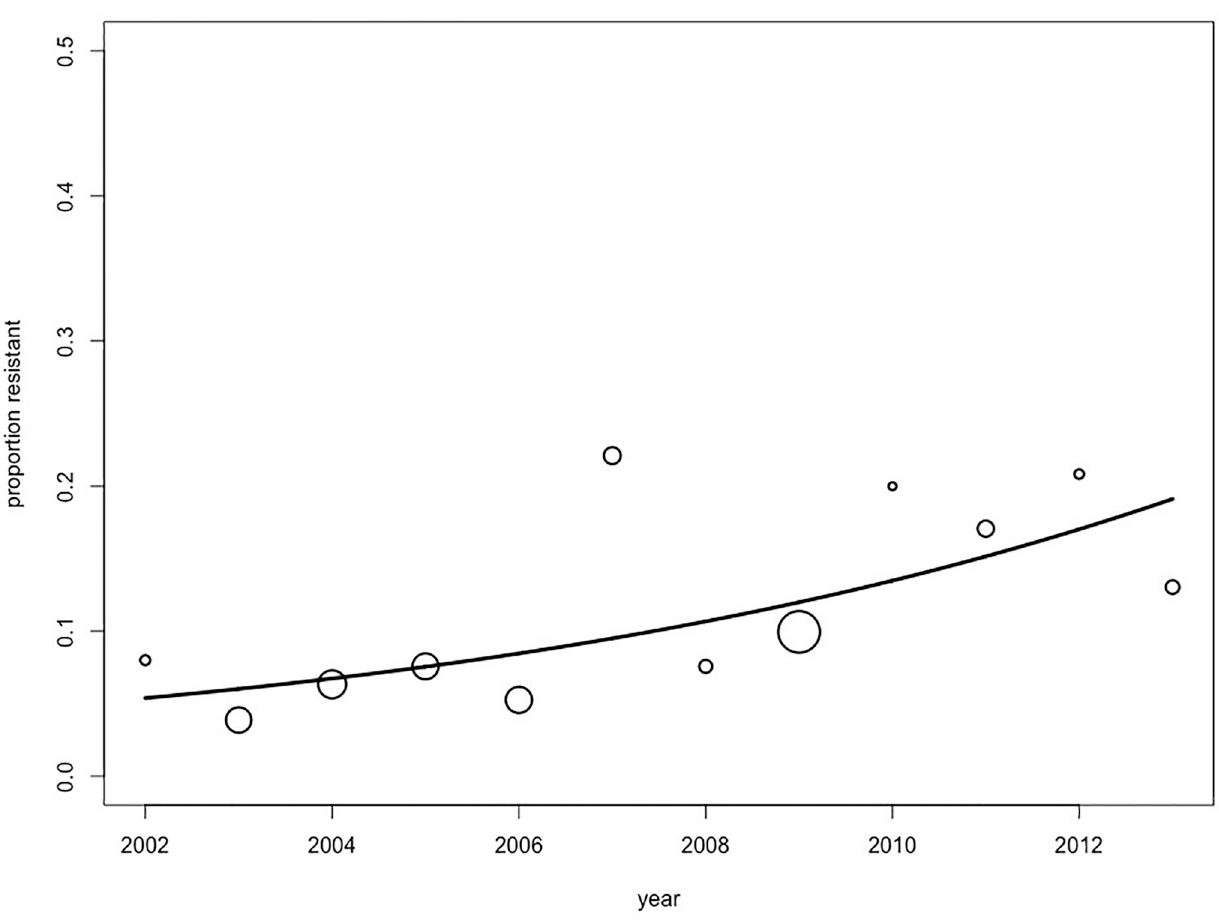
Fig 4. The CIPR data with fitted model. Scatterplot of observed proportions of resistant isolates by year, with bubble size proportional to the number of isolates. Solid line is the fitted model for the probability for an isolate to be resistant, as a function of time, and based on the final model 7.